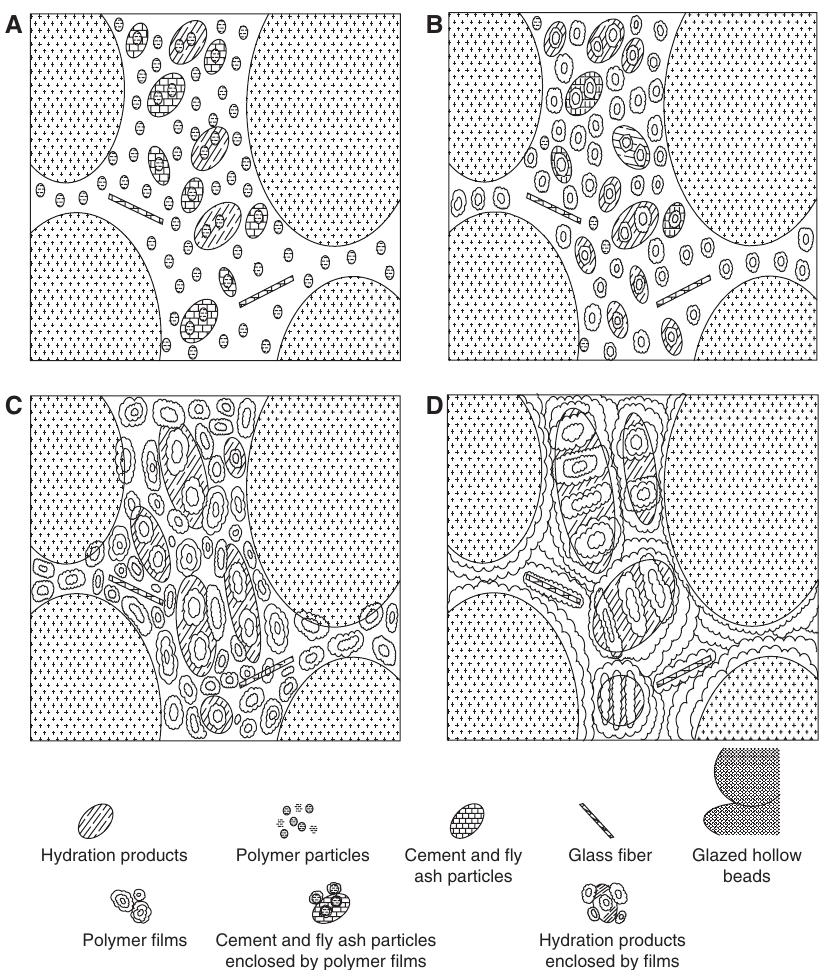
Figure 7 Models of structure formation of insulation material. (A) Shortly after the mixing. (B) Start of formation of polymer films. (C) Formation of a large area of polymer films. (D) Mutual cross-linking of hydration products and polymer